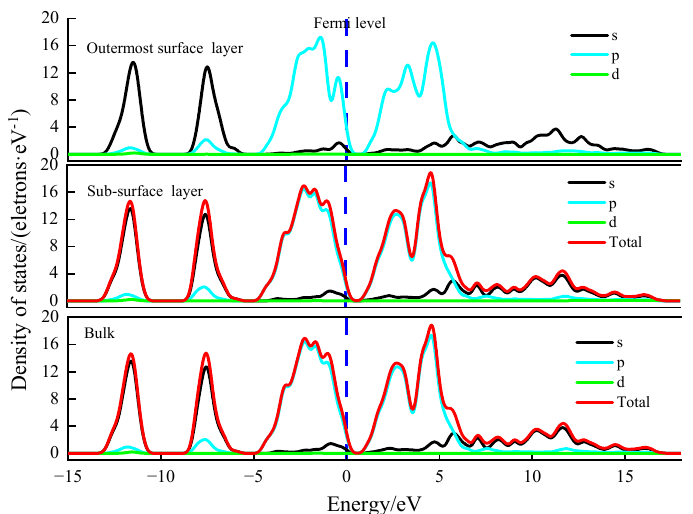
Figure 10. The density state of S atoms of the outermost surface layer, sub-surface layer, and bulk on (100) surface of the galena.